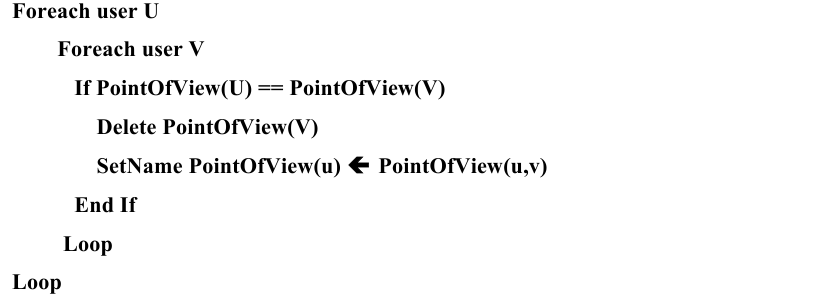
Fig. 3. Algorithm of redundancy